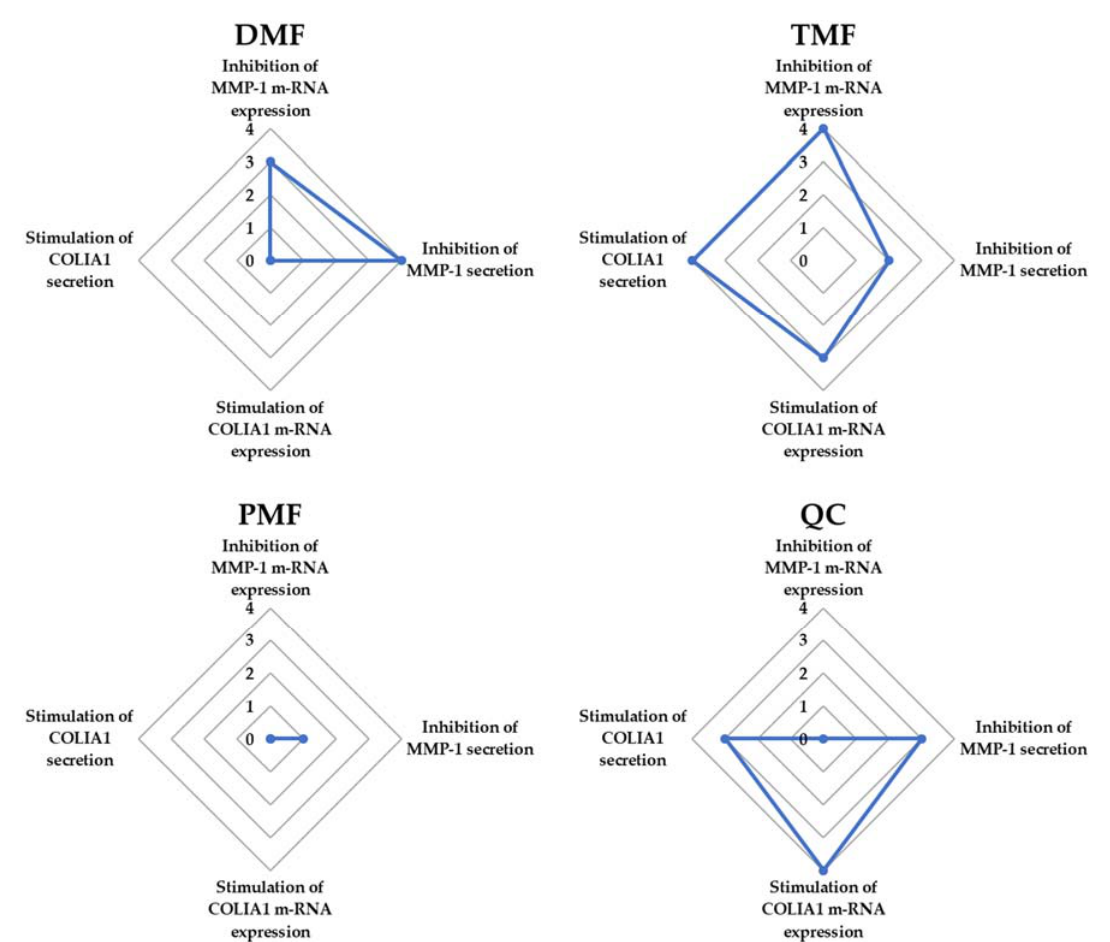
Figure 6. The spider chart for the efficiency comparison of DMF, TMF, PMF, and QC (positive control) on five markers associated with HDF damage, such as inhibition of MMP-1 mRNA expression, inhibition of MMP-1 secretion of MMP-1, stimulation of COLIA1 mRNA expression, and stimulation of COLIA1 secretion. The scores were defined from four, corresponding to the strongest effect, to 1, corresponding to the lowest effect, among the four tested samples, in addition to 0, corresponding to no effect on each factor. Abbreviations: DMF, 5,7-dimethoxyflavone; TMF, 5,7,4 (cid:48) -trimethoxyflavone; PMF, 3,5,7,3 (cid:48) ,4 (cid:48) -pentamethoxyflavone; and QC,